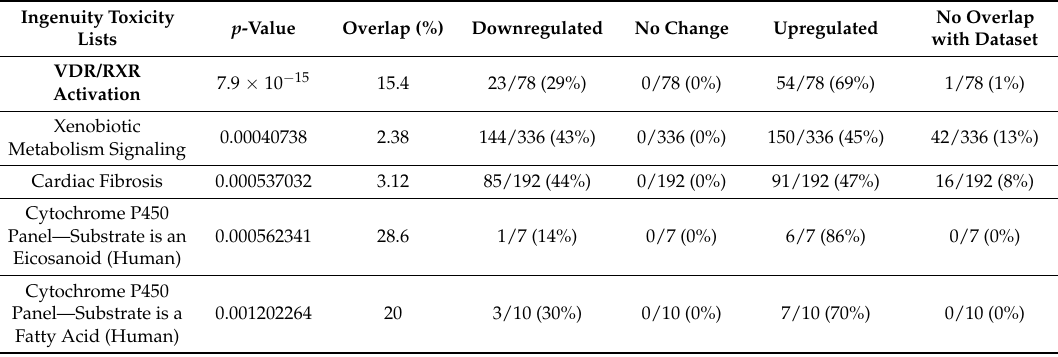
Table 10. Toxicity-related pathways identified by Ingenuity in human keratinocytes treated with 1,25(OH) 2 D3 for 24 h. Nuclear receptors are marked in